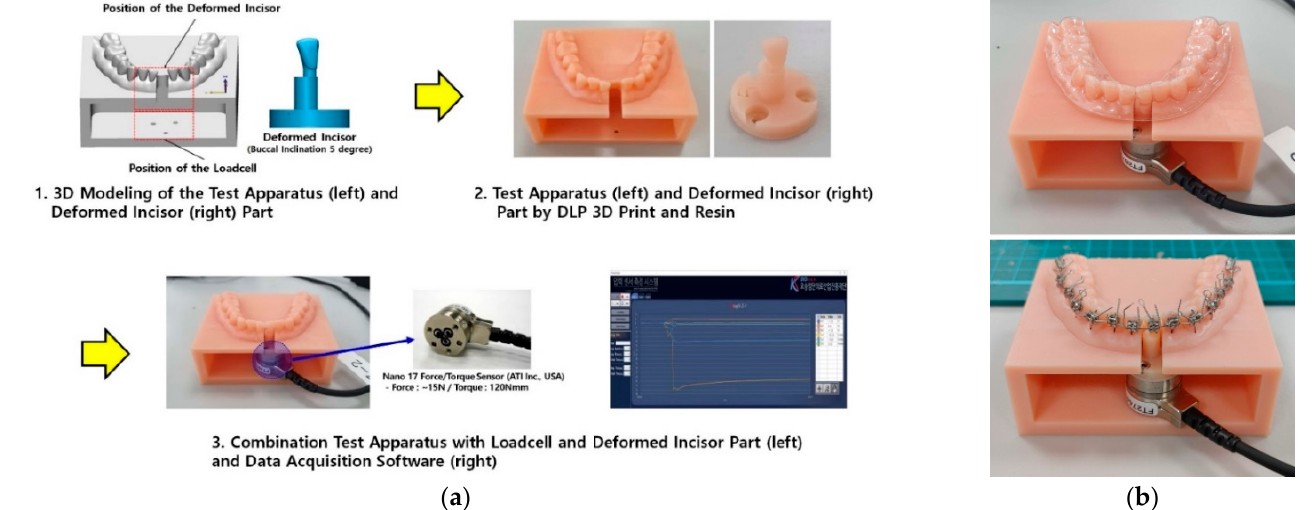
Figure 7. In-vitro orthodontic force measurement environment establishment and testing. ( a ) (1), The central incisor for evaluation of orthodontic force was removed from the 3D-shape data used in the verification orthodontic model. The central incisor mounted on the loadcell was inclined at 5° in the buccal direction. A frame that could hold the loadcell was integrated with the orthodontic model to design the test jig. (2), Thereafter, the test jig was printed using a photo-cured 3D-printer and photo-cured resin material for printing of dental models. (3), After printing, the loadcell and central incisor were combined and placed onto a test jig. The loadcell was connected to the orthodontic force measurement software for data acquisition. ( b ) Data were recorded for 24 h per specimen for each orthodontic appliance. Data were acquired at a rate of 10 Hz for the first 10 min. Thereafter, data were acquired at a rate of 1 Hz for 23 h and 50 min.